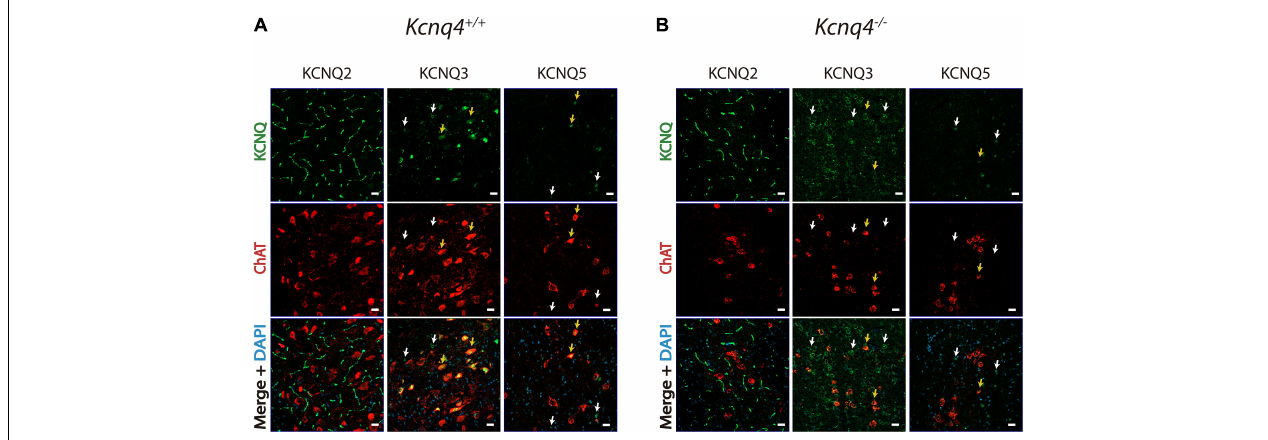
FIGURE 3 | Expression of the other neuronal KCNQ subunits in the PPN. KCNQ2, KCNQ3, and KCNQ5 staining of coronal PPN sections in wild-type (WT, Kcnq4 + / + ) (A) and knockout (KO, Kcnq4 − / − ) (B) mice. KCNQ2 was found in neuron fibers without co-localization in cholinergic neurons. KCNQ3 and KCNQ5 were located in the soma of both cholinergic (yellow arrows) and non-cholinergic neurons. For KCNQ2 and KCNQ5, there was no difference between genotypes. Besides, KCNQ3 in KO animals labeled mostly non-cholinergic (white arrows) neurons. Upper panel : KCNQ subunit ( green ). Middle panel : ChAT ( red ). Bottom panel : merged with DAPI. Scale bar , 20 µ